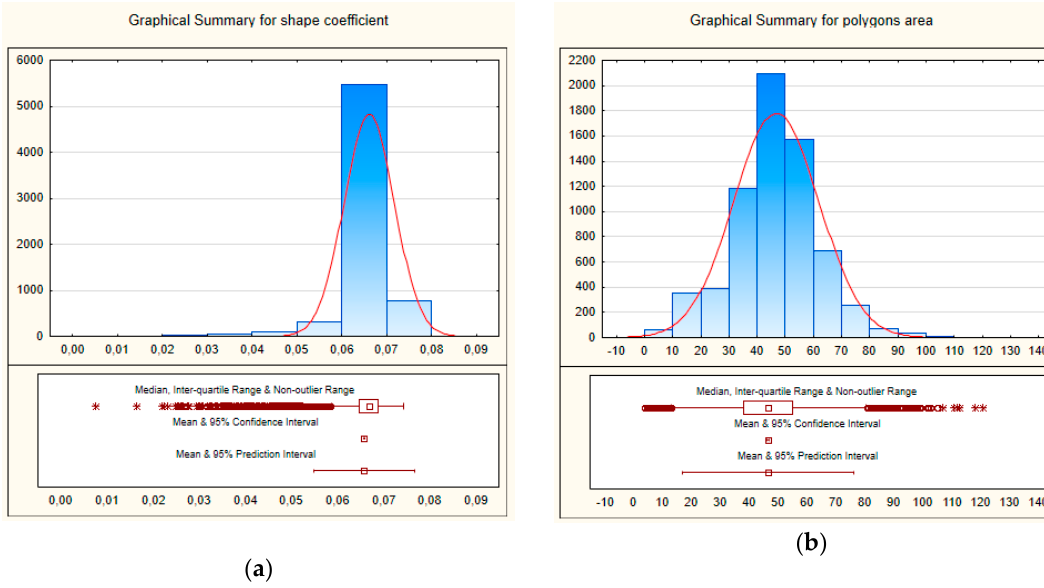
Figure 8. Thiessen polygons’ distribution: ( a ) Shape histogram; ( b ) area histogram.